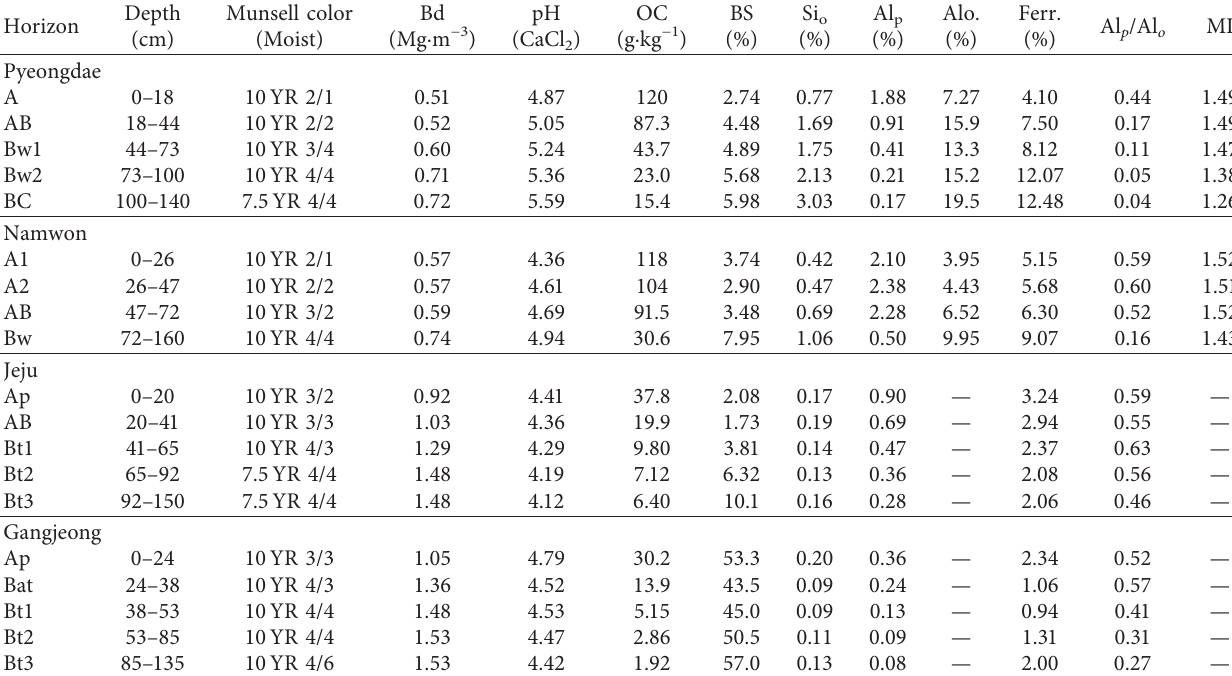
Table 2: Physical and chemical properties of the soils studied in Jeju Island.